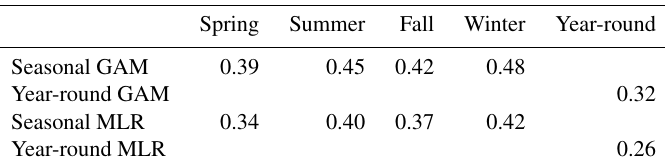
Table A1. Model fitting average R 2 value of the seasonal generalized additive model (GAM), year-round GAM, seasonal stepwise multiple linear regression (MLR), and year-round MLR.